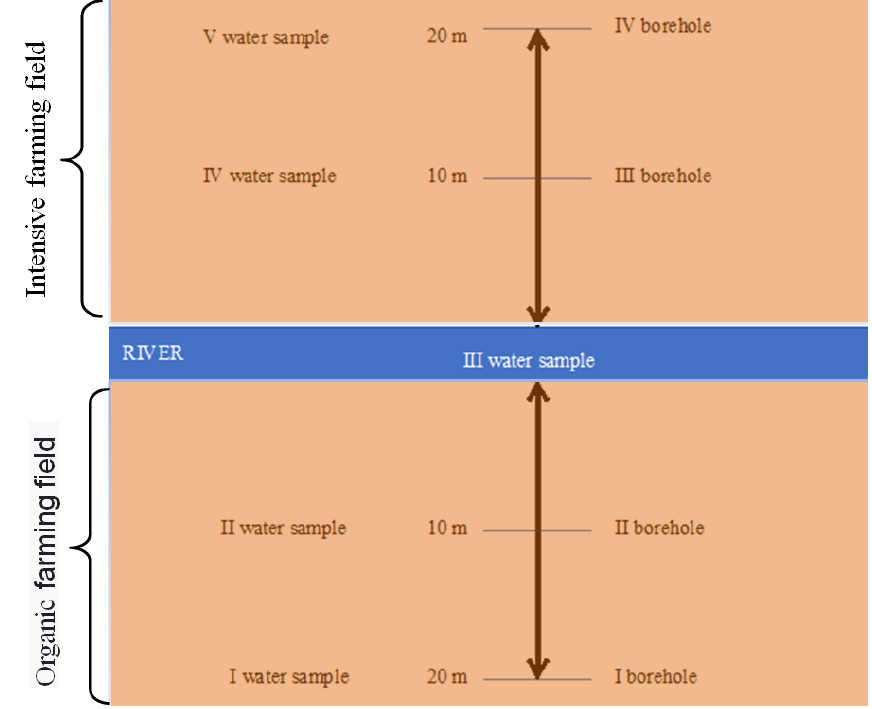
Figure 2. Surface and groundwater sampling scheme.